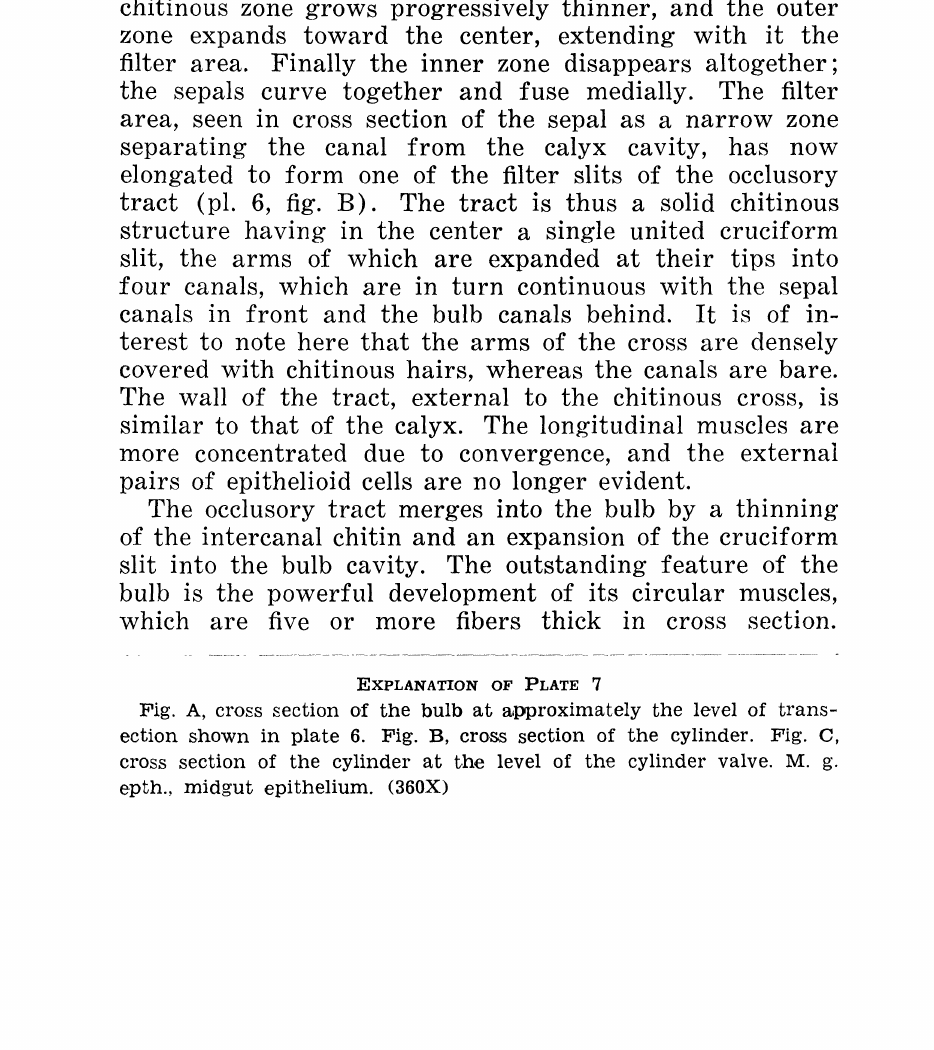
Fig. A, cro.s ection of the bulb at a,pproximately the level of trans- ection shown in plate 6. Fig. B, cross section of the cylinder. Fig. C, cross section of the cylinder at t.he level of the cylinder valve. M. g. epth., midgut epithelium.